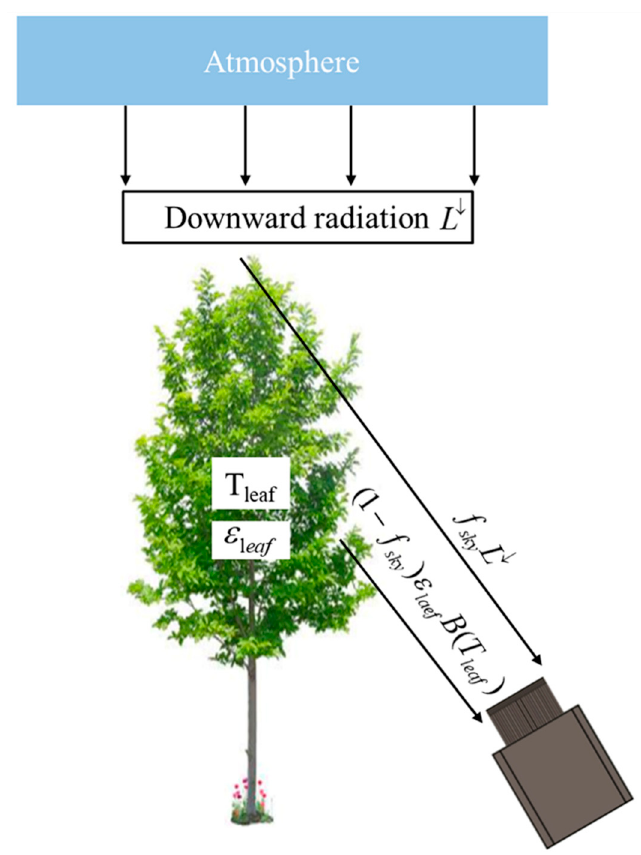
Figure 3. Schematic diagram of the total energy recorded by the thermal imager. The energy received by the thermal imager comes from the canopy radiation energy and the atmospheric downward radiation. The weight of the two is related to the proportion in the FOV.